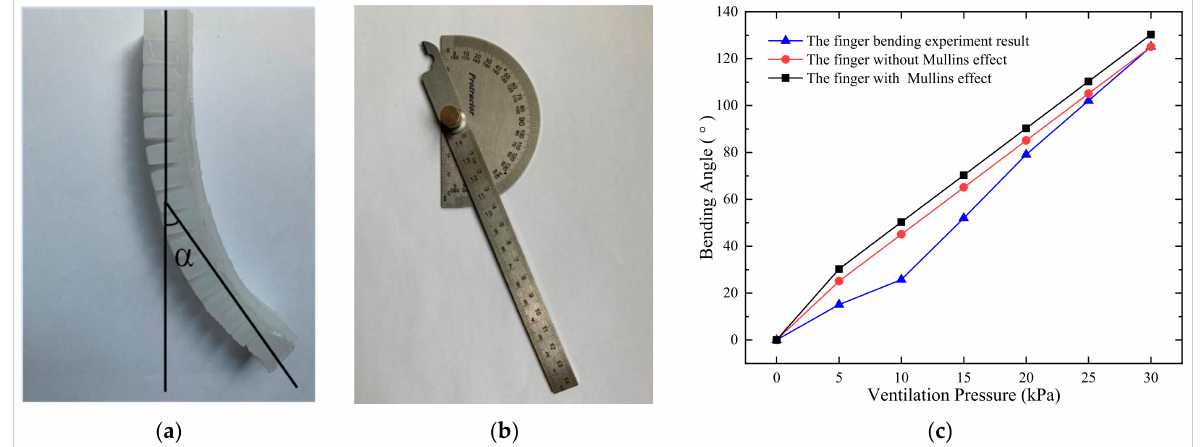
Figure 12. ( a ) Bending angle definition; ( b ) angle measuring ruler; ( c ) comparison between the experimental results of bending angle and with or without the Mullins effect.